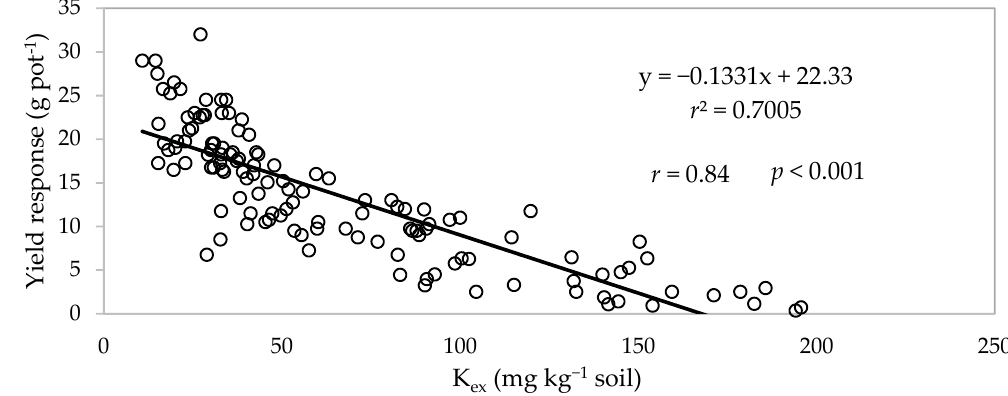
Figure 5. The relationship between initial exchangeable soil K (K ex ) for 18 diverse soils of Bangladesh and yield response of rabi maize grown up to V10–V12 for seven successive crops to K fertilizer in pot experiment, Gazipur, Bangladesh.